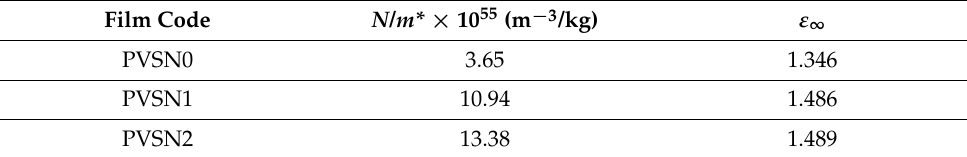
Table 4. Presents the values of N/m* and ε ∞ for PVA loadedSn 2+